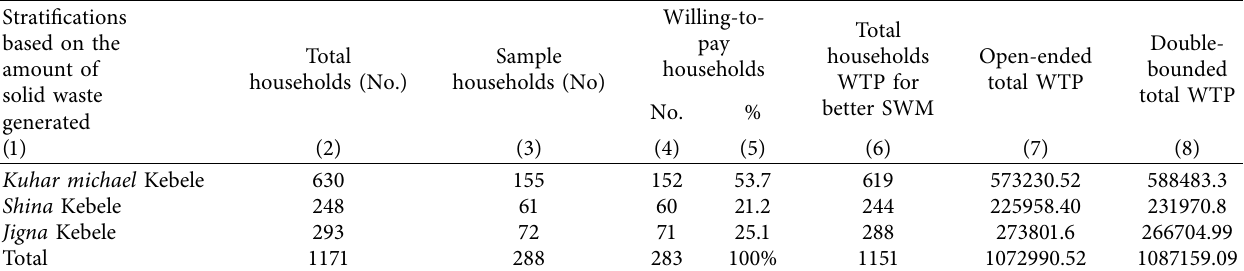
Table 8: Estimated total willingness to pay from open-ended and double-bounded dichotomous choice. Stratifications